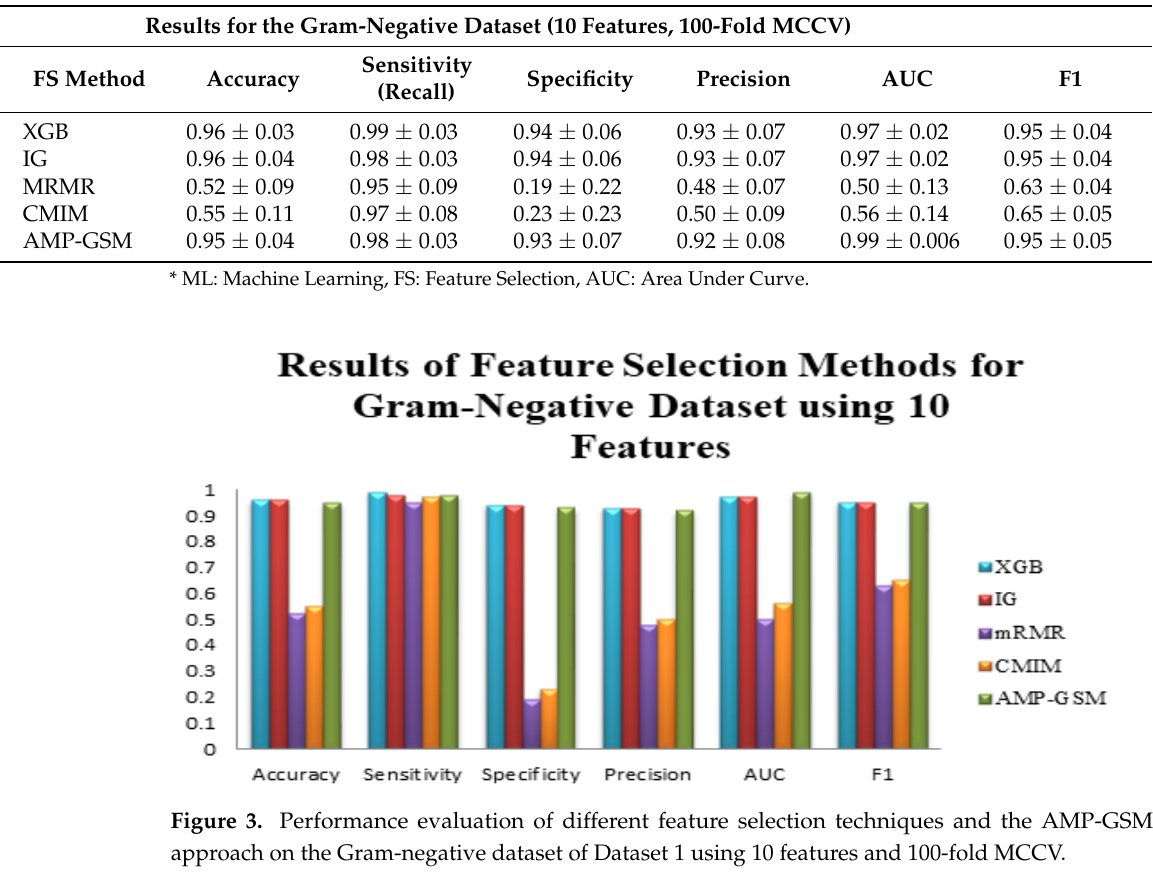
Table 6. Performance metrics of different feature selection techniques with 10 features on the Gram- negative dataset of Dataset 1, using 100-fold MCCV *.